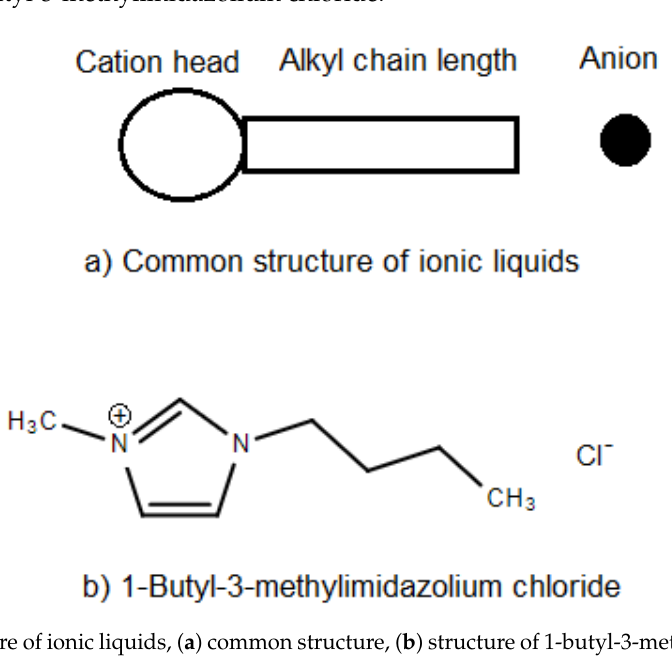
Figure 5. Structure of ionic liquids, ( a ) common structure, ( b ) structure of 1-butyl-3-methylimidazolium chloride [91].